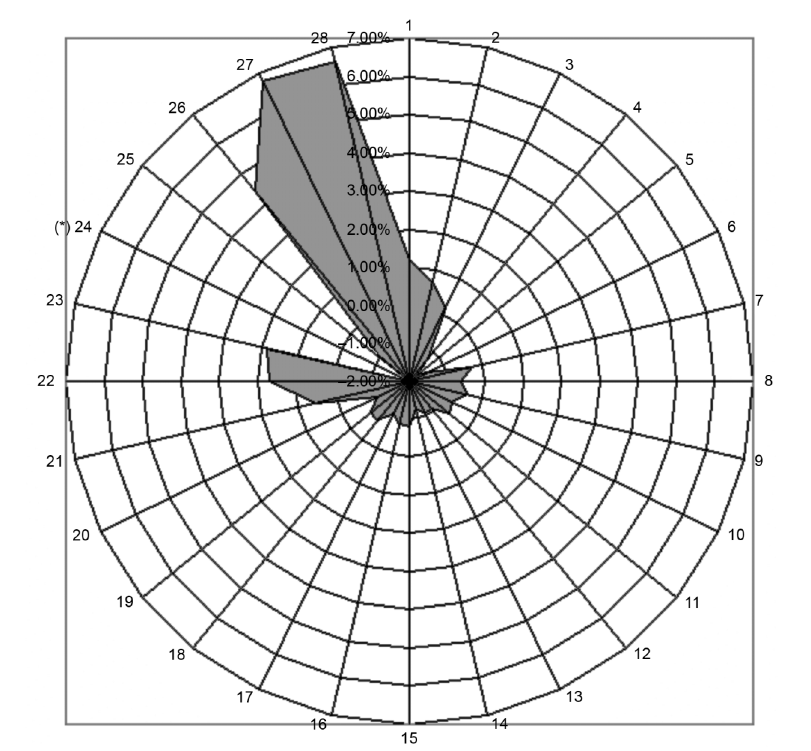
Fig. 3. Comparison between ground tests and OTF tests. Differences in at-sensor-radiance stands out between 1% and 2% in the VIS (ranging from 430 nm to 830 nm wavelength) and more than 6.5% in the NIR (ranging from 1.150 nm to 1.550 nm wavelength). (*) = spectral band not working during the